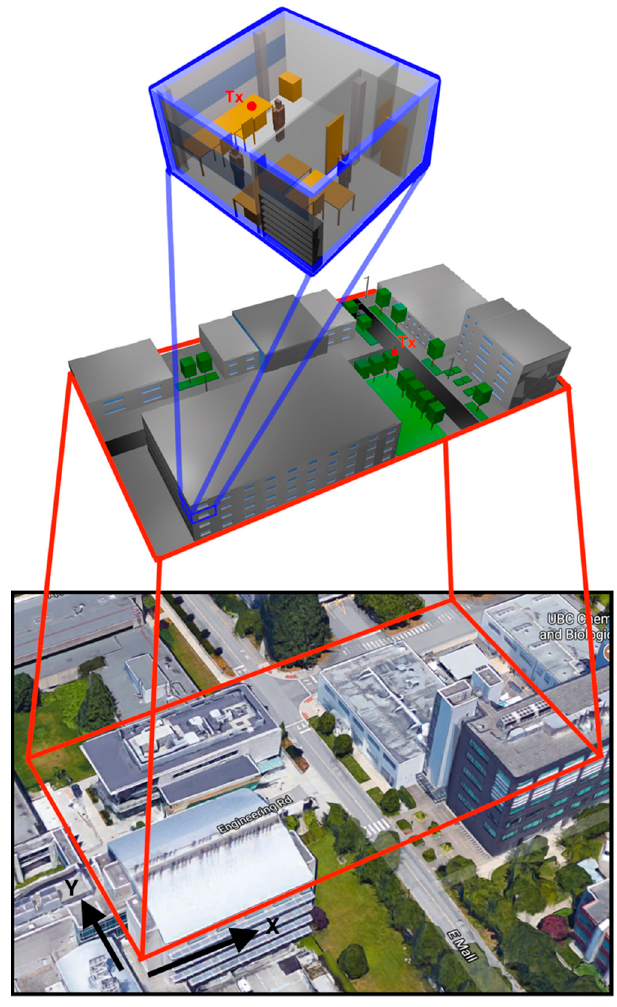
Figure 3. Real aerial view of the considered scenario alongside the schematic representation of the simulated scenarios (outdoor and indoor) and the employed 3D ray-launching parameters for each of the considered scenarios.